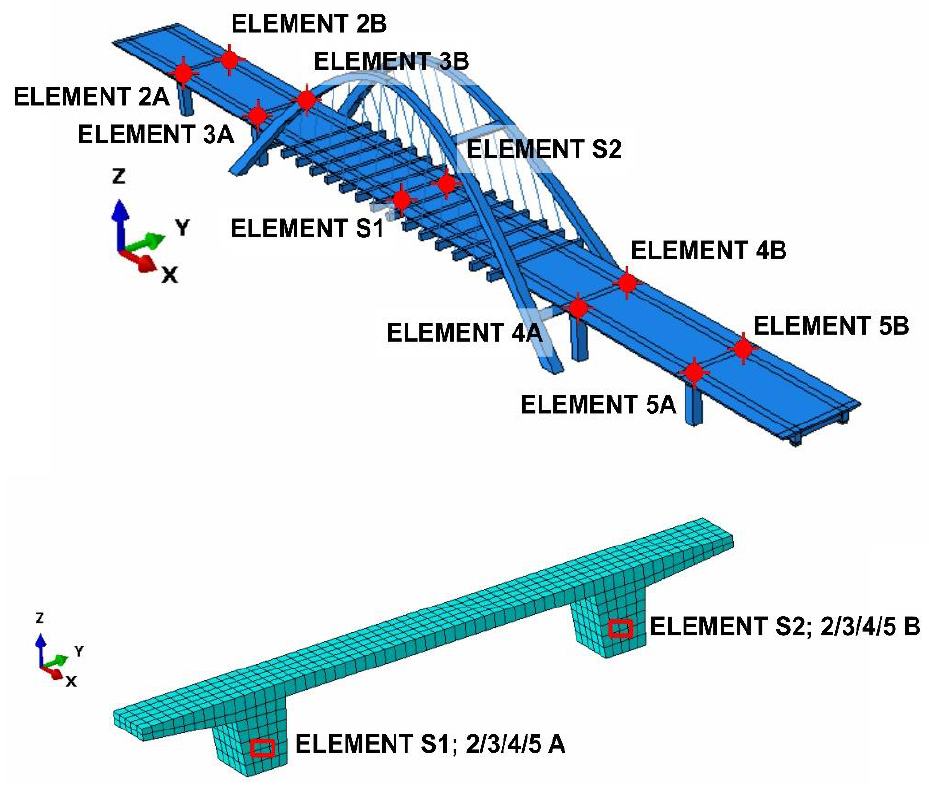
Figure 17. Elements chosen for